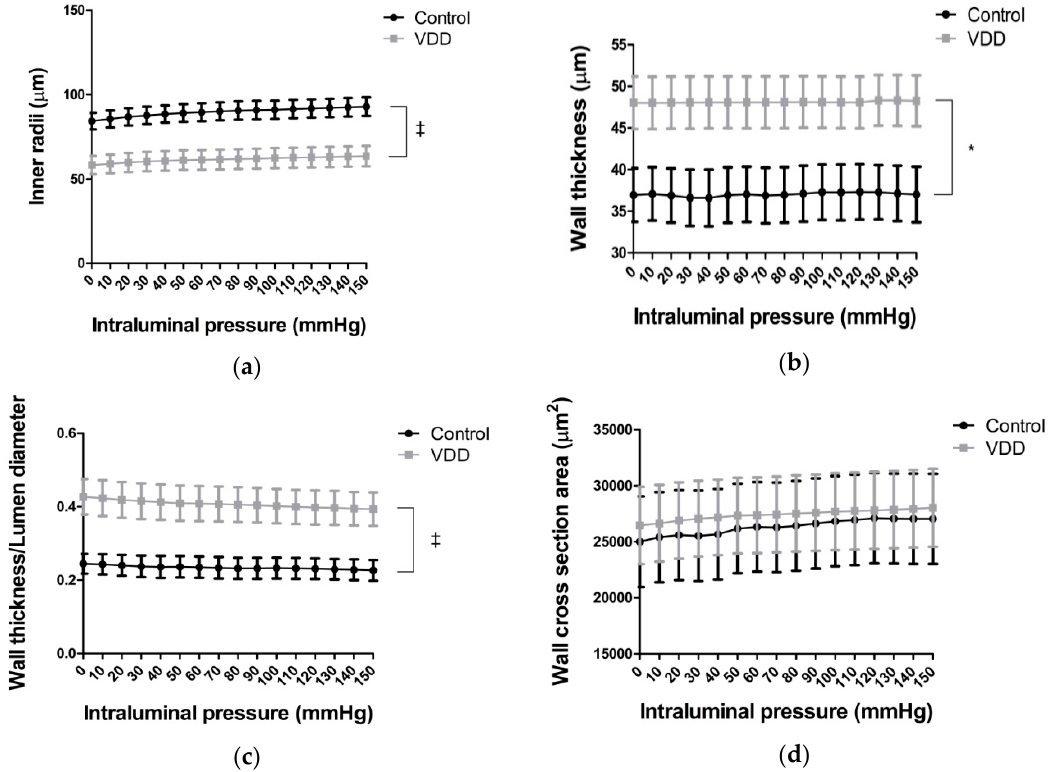
Figure 1. Geometry of coronary arterioles. ( a ) Inner radii ( μ m, n = 8–8); ( b ) wall thickness ( μ m, n = 8–8); ( c ) wall thickness/lumen diameter ratio ( n = 8–8), and ( d ) wall cross-section area ( μ m 2 , n = 7–7) of coronary arterioles in calcium-free solution on 0–150 mmHg intraluminal pressures. Repeated measures ANOVA, Bonferroni. Mean ± SEM, *: p < 0.05; ‡: p < 0.01.